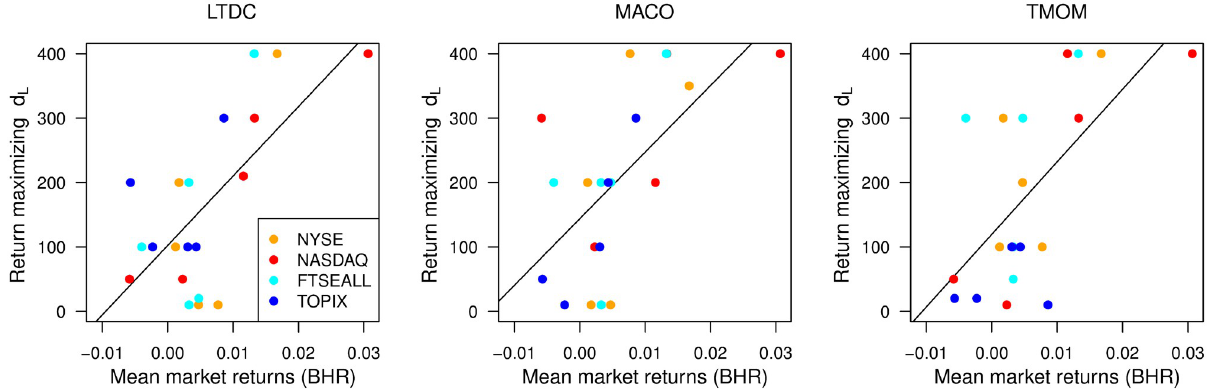
Fig 12. The profit-maximizing d L value and mean market returns. In two-way ties, the mean d L values are used.